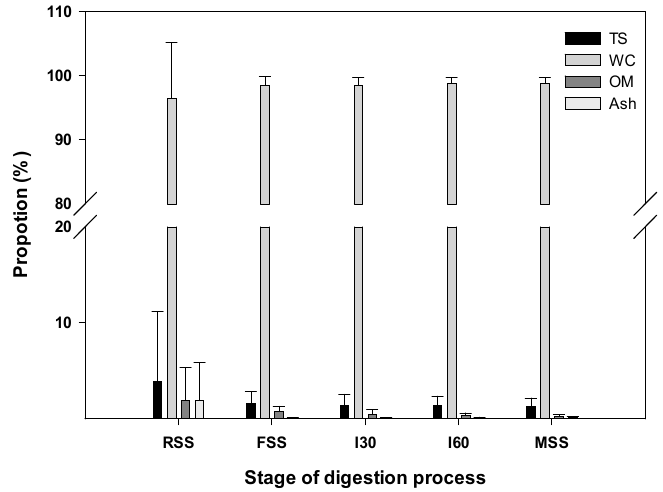
Figure 2. Changes of mean proportion of physical properties from RSS to MSS.